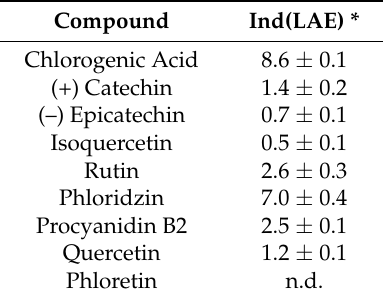
Figure 5. AAE and LAE affect ex vivo cultures of cells carrying FAP mutations. Cell viability, cell number and proliferation rate of human colonic biopsies cultured for 24 h and 48 h in a culture medium supplemented with LAE (400 mg/L) or with vehicle (DMSO). Values are expressed as mean ± SEM ( n = 9). *** p < 0.05. Table 3. Polyphenolic content of industrial-scale food-grade